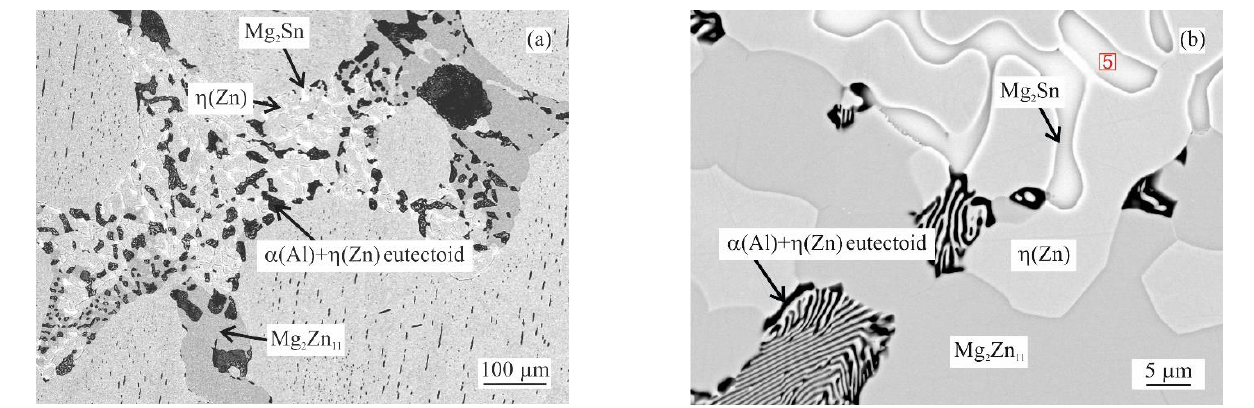
Figure 3. Quaternary eutectic area in MZ + 0.5Sn alloy microstructure after DSC measurement: ( a ) example of quaternary eutectic; ( b ) closer detail of such area including EDS measurement point 5 listed in Table 2.